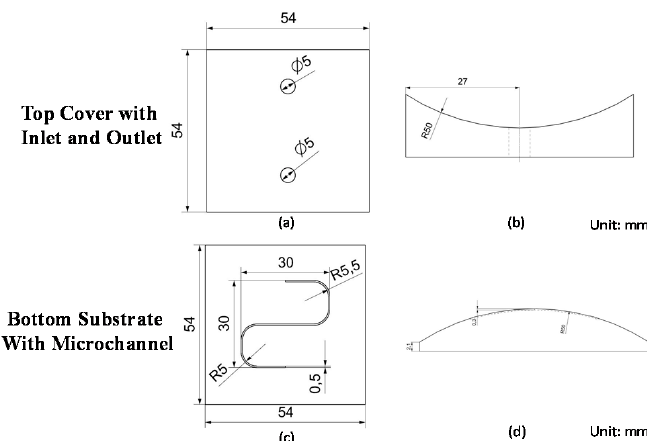
Figure 1. Layout of nonplanar microfluidic chip with S-microchannel: ( a ) design and dimensions of top cover (top view); ( b ) design and dimensions of top cover (side view); ( c ) design and dimensions of bottom substrate (top view); ( d ) design and dimensions of bottom substrate (side view).